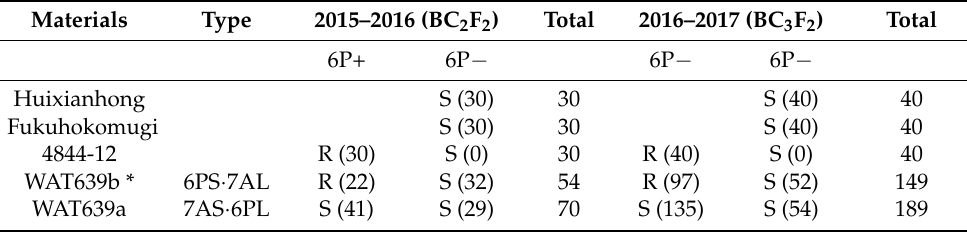
Table 2. Response to stripe rust in populations of 6P whole-arm translocation